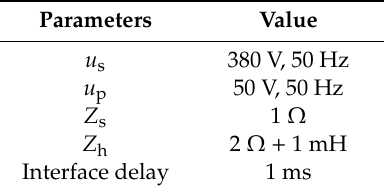
Table 1. System simulation parameters.